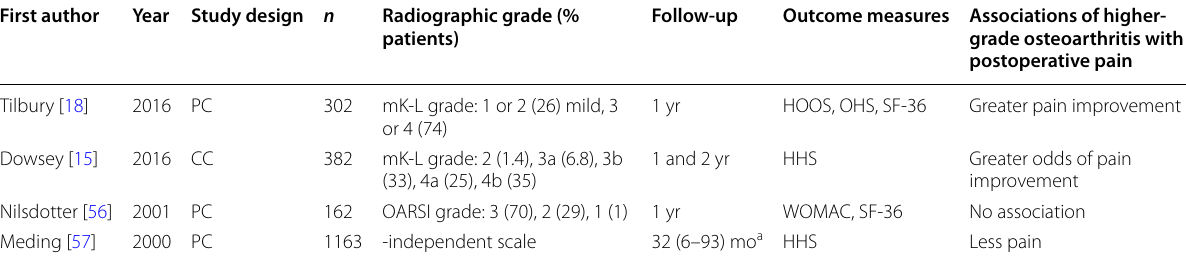
CC Case–control, HHS Harris Hip Score, HOOS Hip Disability and Osteoarthritis Outcome Score, mK-L modified Kellgren and Lawrence grade, OARSI Osteoarthritis Research Society International, OHS Oxford Hip Score, PC Prospective cohort, SF-36 36-Item Short-Form Health Survey, WOMAC Western Ontario and McMaster Universities Arthritis Index a Expressed as mean (range)